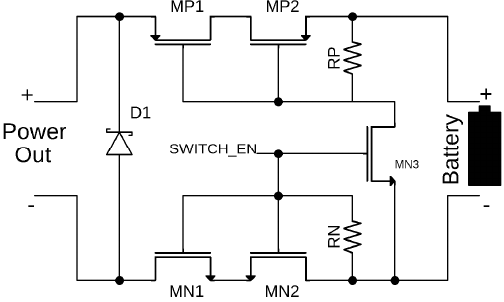
Figure 2. Schematic of the battery switching unit.